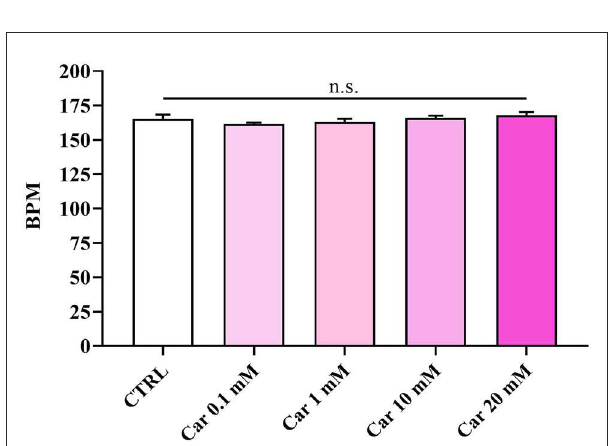
FIGURE2 Beats per minute (BPM) of unexposed larvae and larvae exposed to increasing concentrations of carnosine (0.1, 1, 10, and 20mM). SD is represented by vertical bars. Car, carnosine; n.s., not